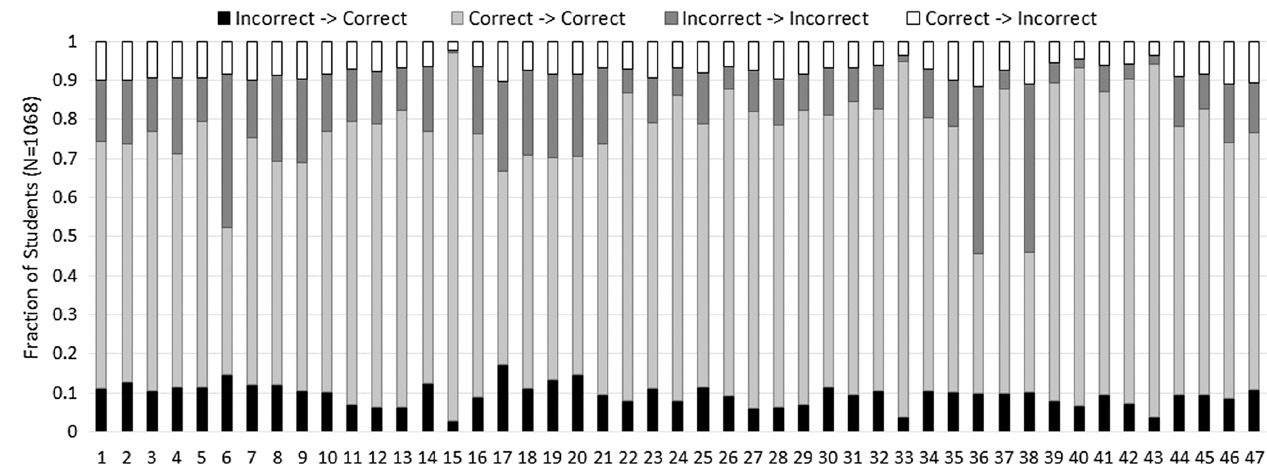
FIG. 3. Fraction of students who exhibited any of the following four response patterns in their responses to each FMCE item between PHYS I and II: (i) an incorrect response in PHYS I that shifted to a correct response in PHYS II, (ii) an incorrect response in PHYS I that stayed an incorrect response in PHYS II, (iii) a correct response in PHYS I that stayed a correct response in PHYS II, or (iv) a correct response in PHYS I that shifted to an incorrect response in PHYS